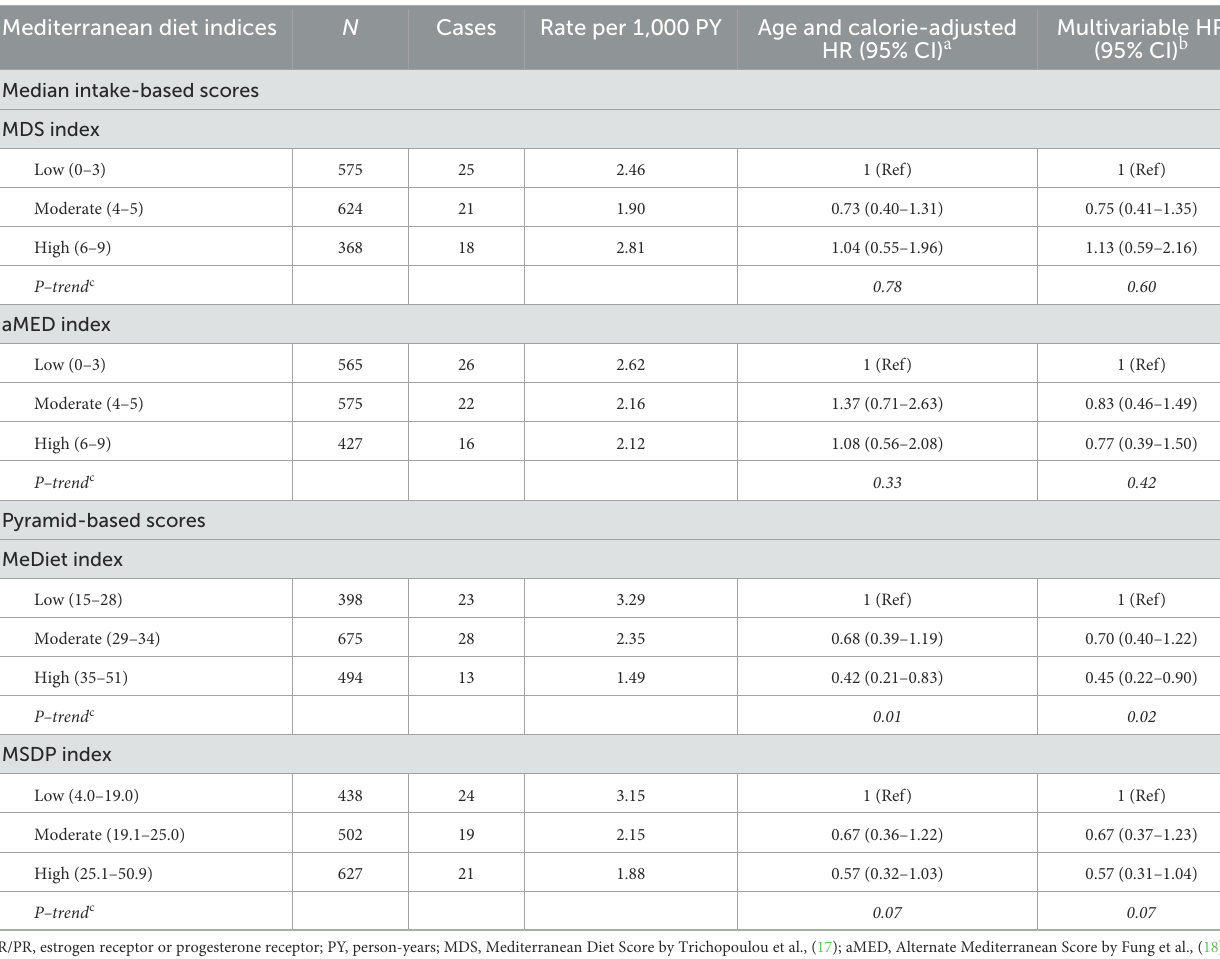
TABLE 5 Hazard ratios for any ER/PR positive breast cancer associated with Mediterranean diet indices. Mediterranean diet indices N Cases Rate per 1,000 PY Age and calorie-adjusted